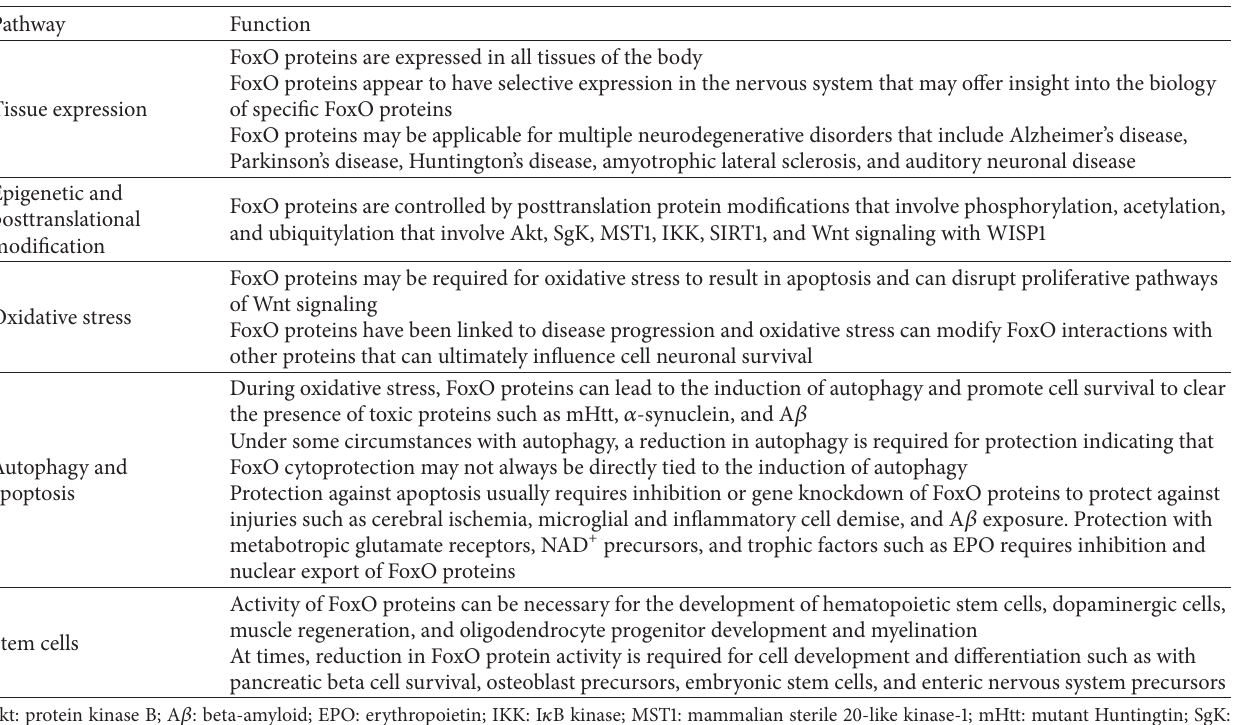
Table 1: Forkhead box class O (FoxO) in the nervous